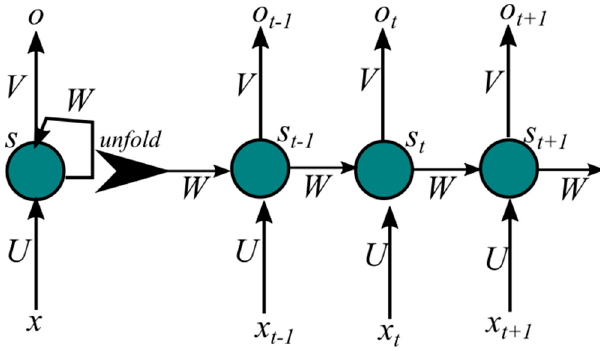
Figure 1. Architecture of a recurrent neural network (RNN).